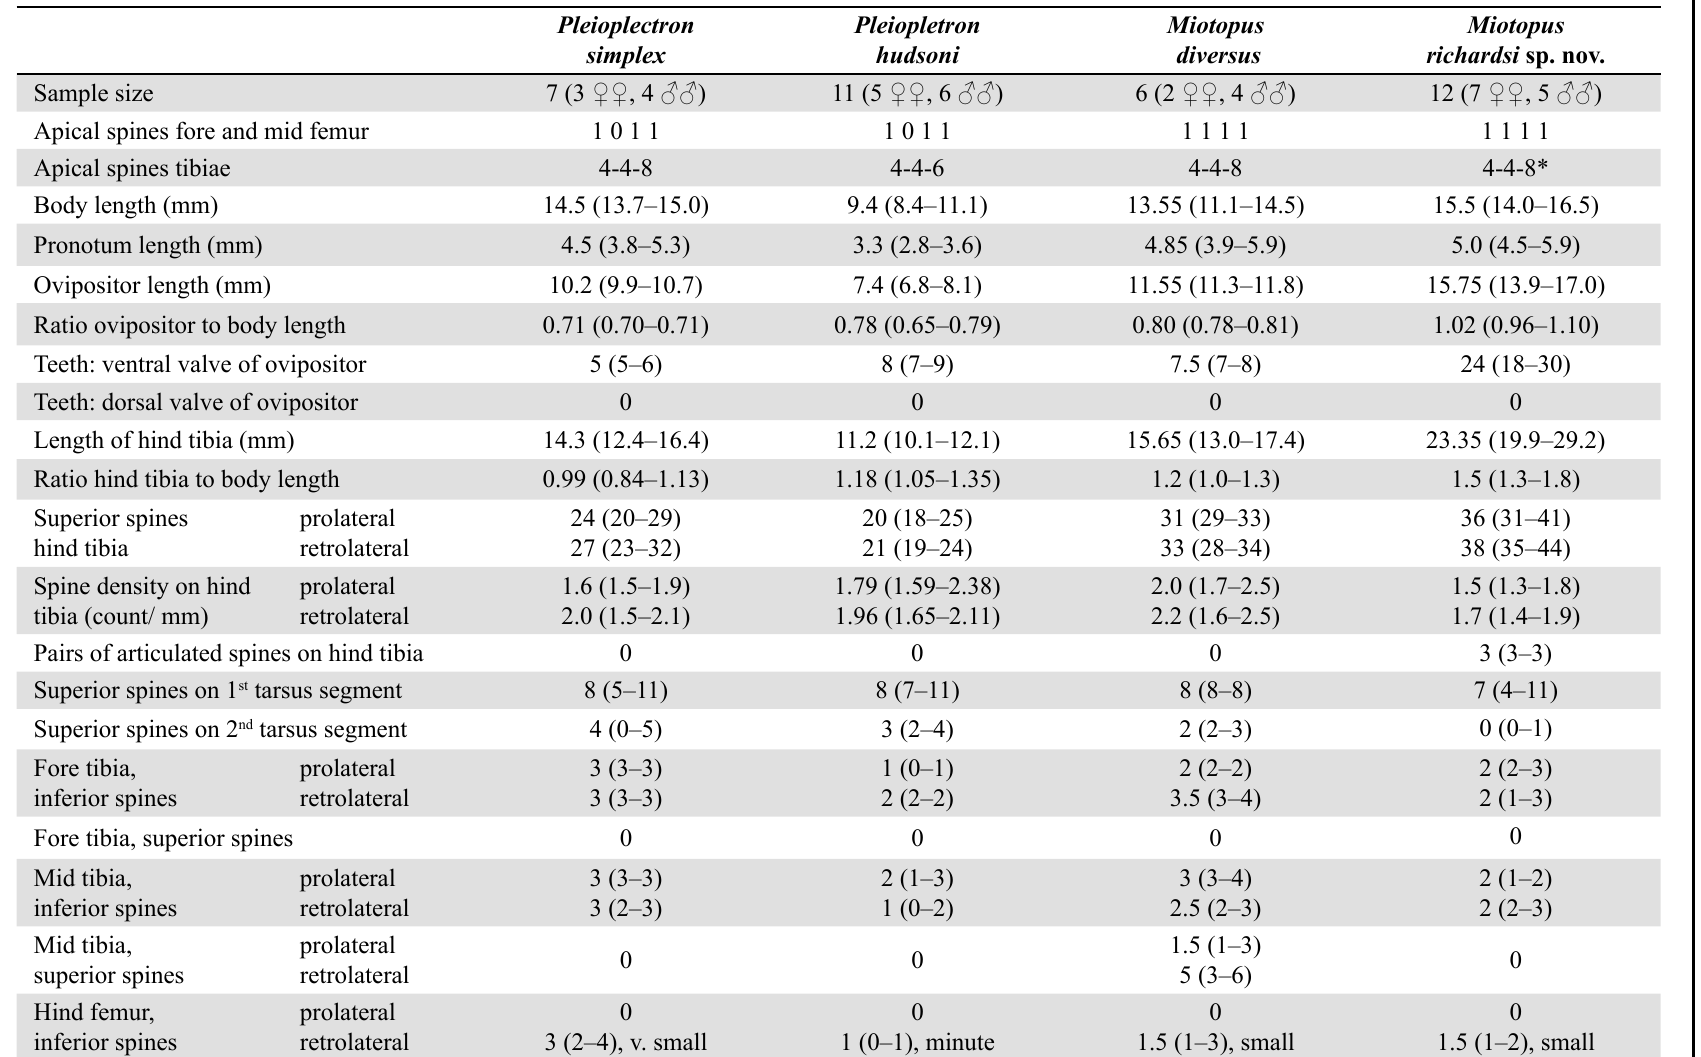
Table 1. Dimensions and spine counts of Pleioplectron hutton, 1896 and Miotopus hutton, 1898 rhaphidophoridae. *(4-4-7 in two Lewis Pass